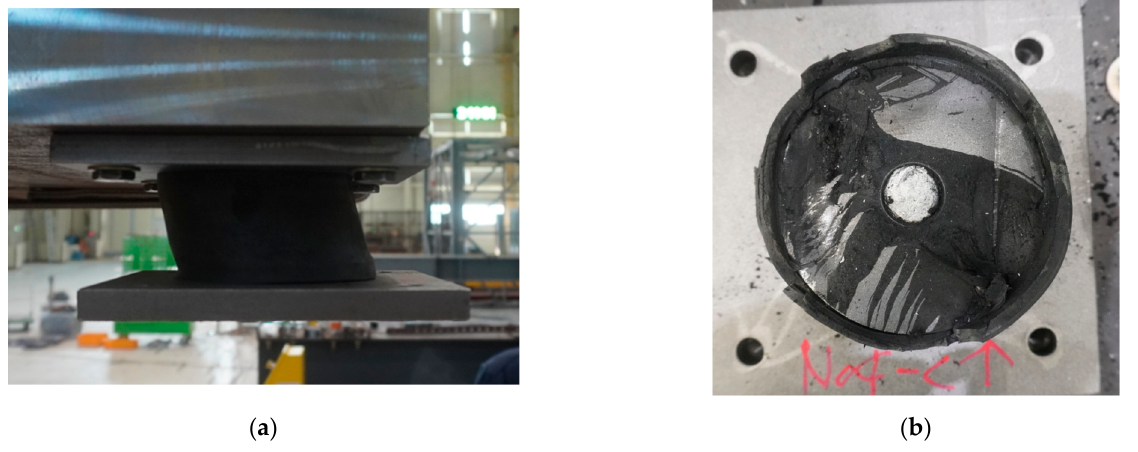
Figure 17. Photos of failed LRB after ultimate test with PGA = 0.6 g (Test ID, OPT-2C-2): ( a ) Front view with permanent deformation; ( b ) Top view with failed section.